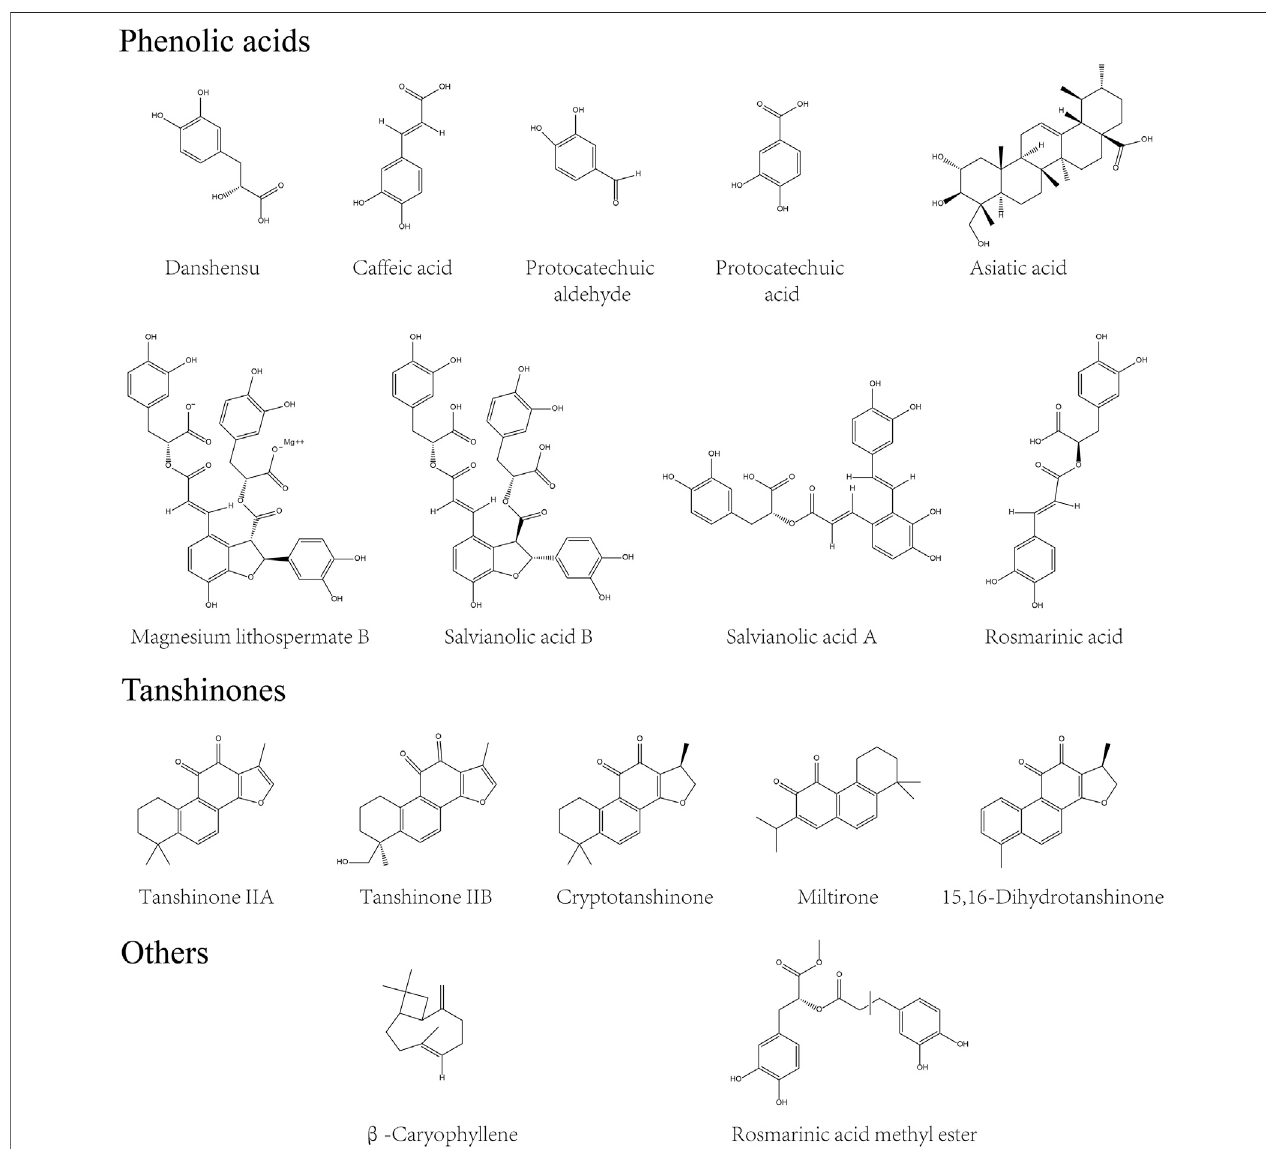
FIGURE1| CharacteristiccompoundsofDanshen.CompoundsderivedfromDanshenweredividedintophenolicacids,tanshinonesandothersbytheirstructural characters and pharmacological effects.